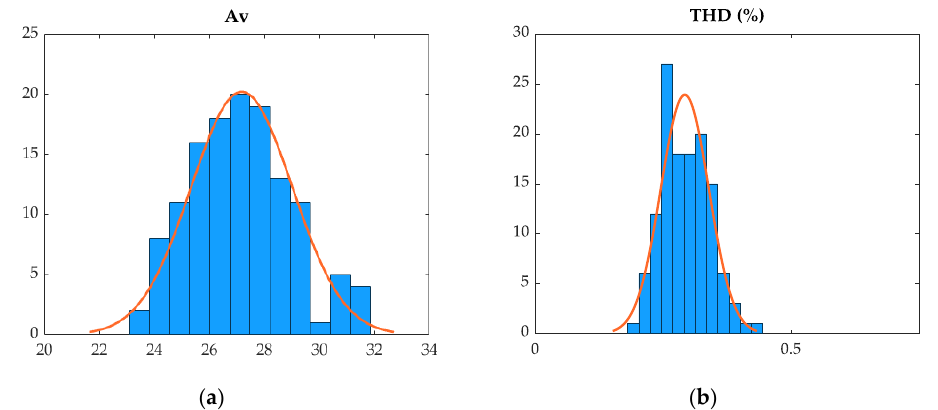
Figure 3. Histograms of the results with the initial design of the amplifier: ( a ) voltage gain (Av); ( b ) total harmonic distortion (THD).